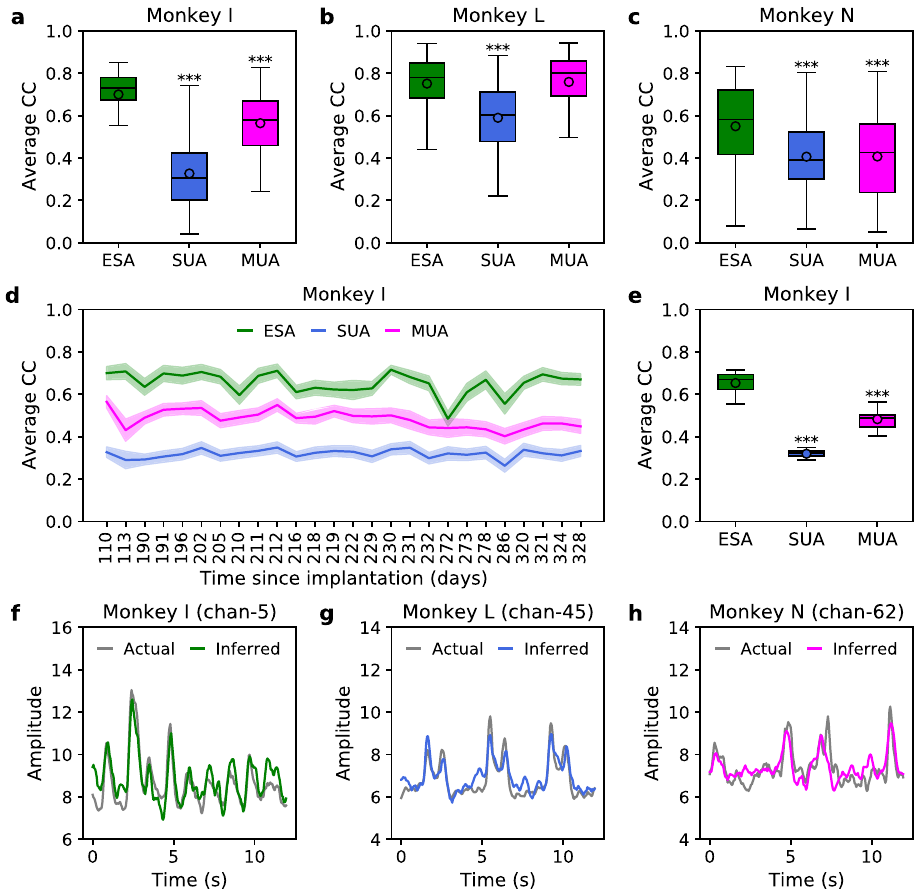
Figure 2. Comparison of inference performance in terms of average CC among different types of spiking activity across three subjects. ( a – c ) Boxplot comparison of average CC among ESA, SUA, and MUA from monkey I, L, and N, respectively. ( d ) Comparison of average CC among ESA, SUA, and MUA from monkey I over 26 recording sessions. ( e ) Boxplot comparison of average CC across 26 recording sessions. Asterisks indicate spiking activity whose inference performance differed significantly from that of ESA (*** p < 0.001